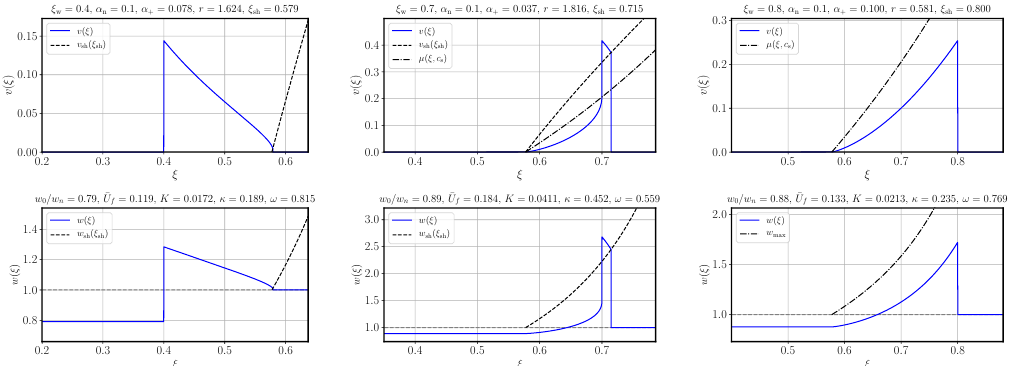
Figure 15: The fluid velocity v and the enthalphy w as a functions of the dimension- less coordinate ξ = r / t for the three classes of solutions is depicted. The wall is located at ξ . The left panel shows the velocity profile for a subsonic deflagration, w where the fluid velocity smoothly decreases from the wall until it reaches a shock ahead of which the fluid is at rest. The middle panel shows supersonic deflagration (hybrid). The right panel shows a detonation, where the velocity smoothly increases until the location of the wall, while the fluid is at rest outside the bubble. The three cases are represented by the blue dots in Fig. 13. Figures taken from Ref. [ 66 ]